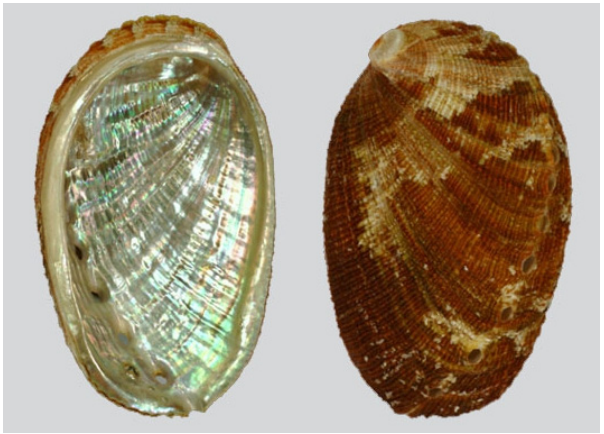
Figure 21. Images of the shell of Haliotis diversicolor squamata. © Natural History Museum Rotterdam (CC BY-NC-SA 4.0); http://www.marinespecies.org/. Euphausia superba (Dana, 1850; Malacostraca, Euphausiacea: Euphausiidae; Figure 22) is a